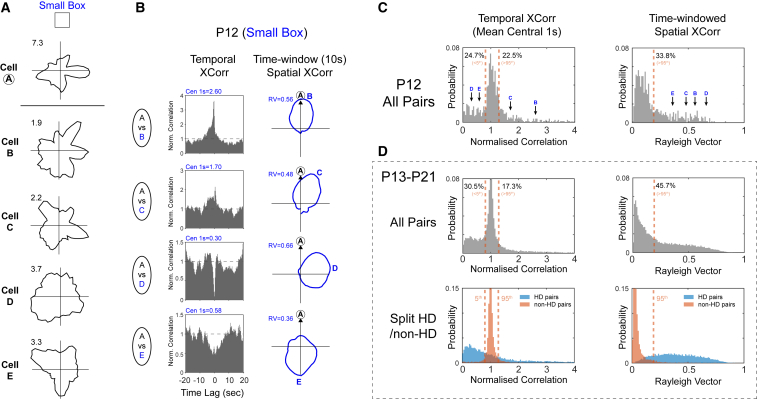
HD Attractor Network Organization Is Present at P12, Even before HD Cells Can Be Anchored to Landmarks(A) Polar plots for five example cells recorded in a small box at P12, showing no HD tuning over a 10-min session.(B) Temporal cross-correlograms (TXCs; left) and spatial cross-correlograms (SXCs; right) between cell A and cells B–E. Blue text at top left shows mean of central 1 s of TXC and RV length of SXC, respectively, for each example.(C) Probability distributions of mean of central 1 s of the TXC (left) and RV length of the SXC (right) scores for all P12 co-recorded cell pairs (n = 452). Black arrows with blue letters indicate scores from examples shown in (A) and (B). Orange dashed lines show the values of the fifth and 95th percentiles of scores of known non-HD cells in older animals (see D; only 95th percentile is shown for SXC). Black text refers to percentages of P12 scores above or below these percentiles.(D) Top row: As for (C) but for all co-recorded cell pairs P13–P21. Bottom row: Same data as top row but distributions of HD-HD pairs (light blue) and nonHD-nonHD pairs (orange) are plotted separately. Orange dashed lines shown here and in (C) and (D) (top row) are derived from the fifth and 95th percentiles of the orange (nonHD-nonHD) distributions. See also Figure S2.